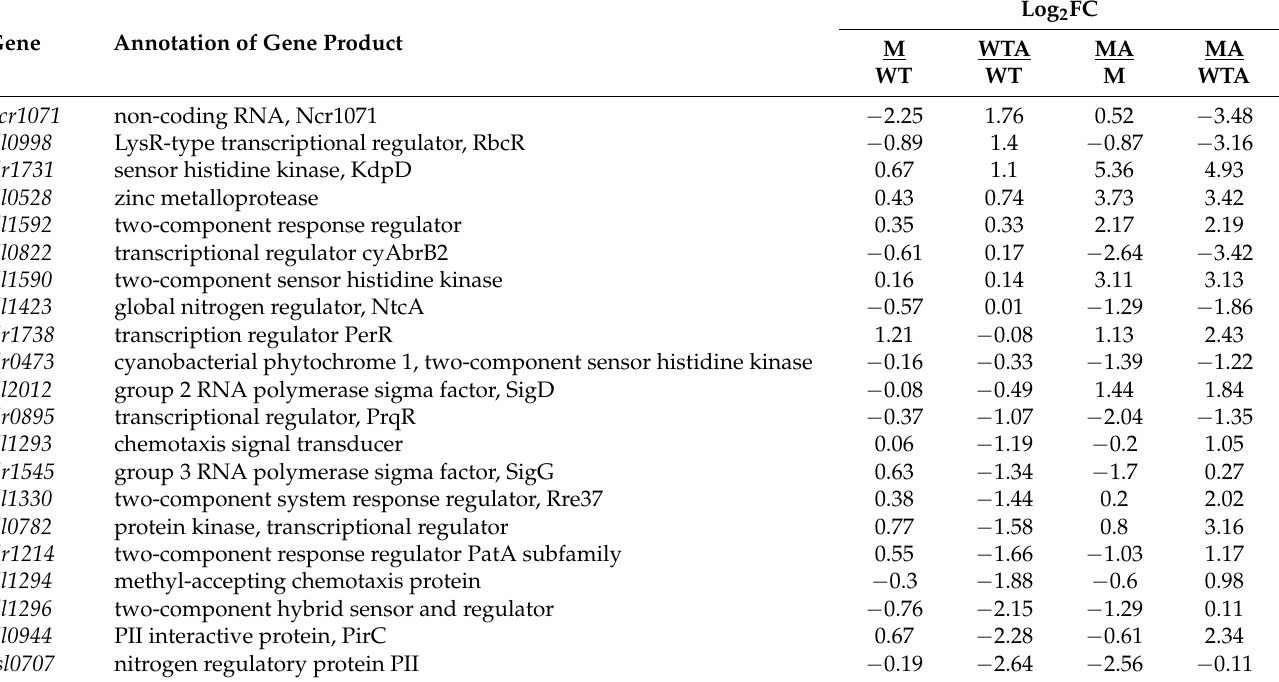
Table 1. Differential expression of regulatory protein or